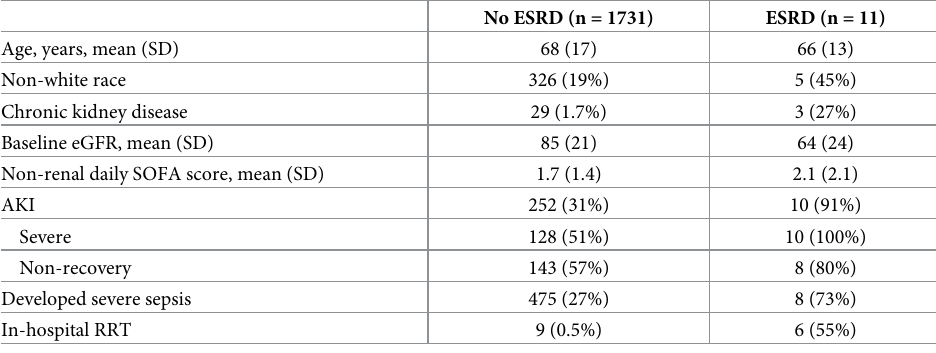
Table ). A model including baseline SCr, AKI on day 1, use of in-hospital RRT Apache III score and CKD showed an area under the ROC curve (AUC) of 0.79 for prediction of recovery by hospital discharge (Hosmer-Lemeshow test statistic: 5.89; p-value 0.66). Table 2. Post-hospitalization